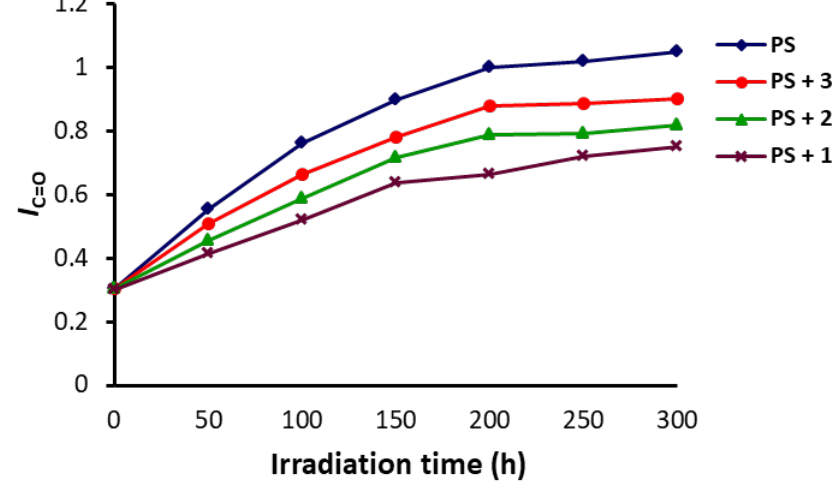
Figure 4. Changes in the I C=O of PS upon irradiation.